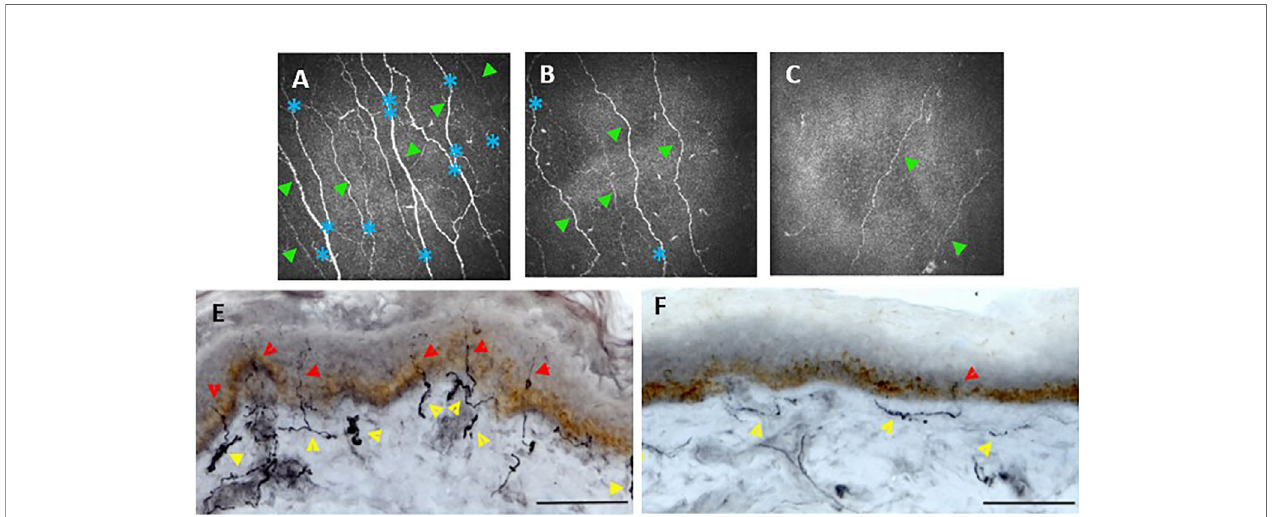
FIGURE 3 | Corneal confocal microscopy images of the corneal, sub-basal nerves (A – C) . Healthy control (A) shows numerous corneal main nerve fi bers (green arrowheads) with branching nerves (blue asterisks). CCM images of patients with diabetes and mild (B) or severe (C) neuropathy demonstrate reduced corneal nerves and branches. Skin biopsies (E, F) immunostained. Healthy control (E) shows numerous intraepidermal nerve fi bers (red arrowheads) with a well-developed subepidermal nerve plexus (yellow arrowheads). A diabetic patient (F) demonstrates reduced subepidermal and minimal intraepidermal nerve fi bers. Scale bar = 100 mm. (E, F) adapted from